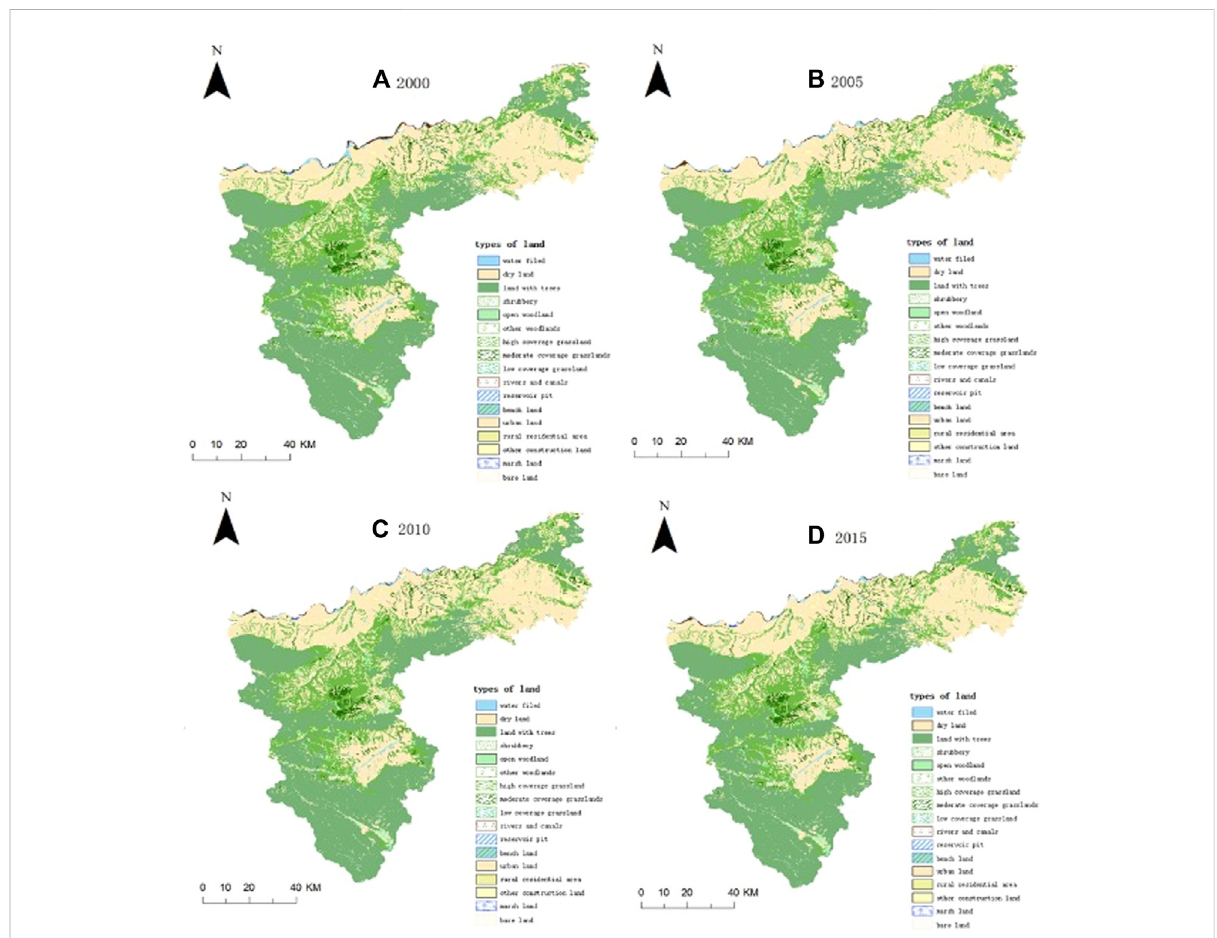
FIGURE 3 ChangesinthefarmlandareaofSanmenxiaCity.(sourcefrom:SanmenxiaNaturalResourcesBureauandtheStatisticalYearbookofSanmentxia City from